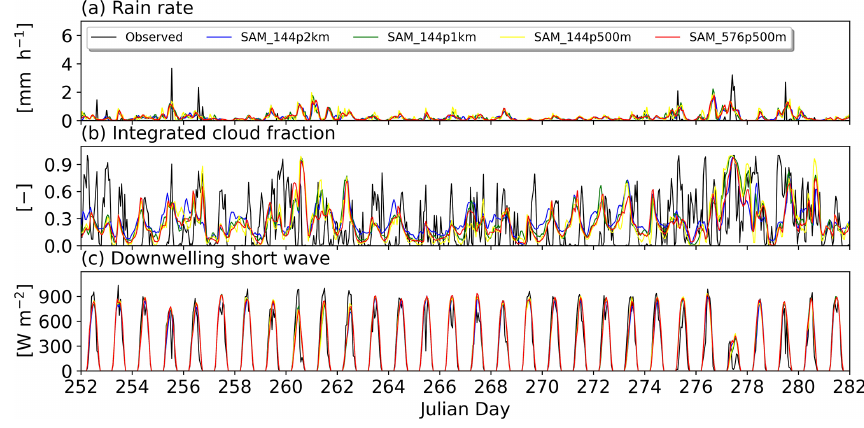
Figure 3. Time series of the domain average of the column-integrated cloud fraction (ranging from 0 for clear sky to 1 for overcast sky 1), precipitation rate (mmh − 1 ) and downward shortwave flux (Wm − 2 ) for the observations and the simulations with the SAM model for IOP2 (dry season). The black line represents the reference data (GoAmazon 2014/15), and the other colors represent the different horizontal resolutions used in the simulations (SAM).